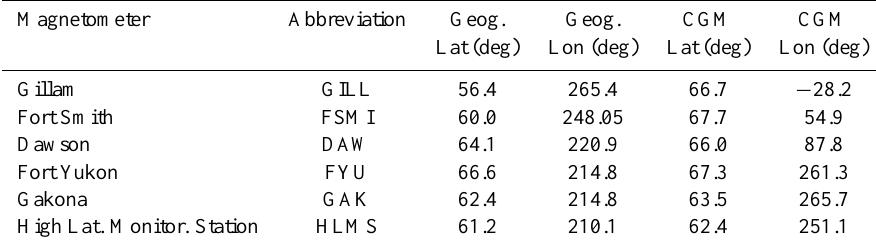
Table 1. Magnetometer notation and location. Magnetometer Abbreviation